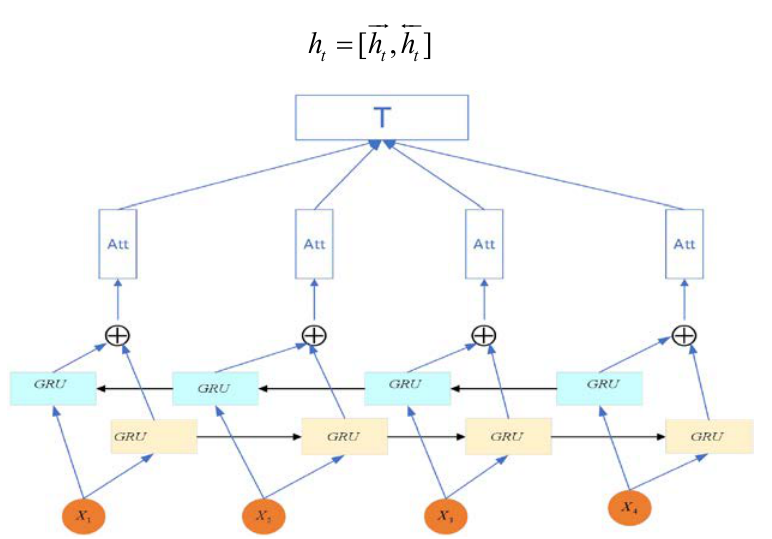
Fig. 4. BiGRU-Attention structure